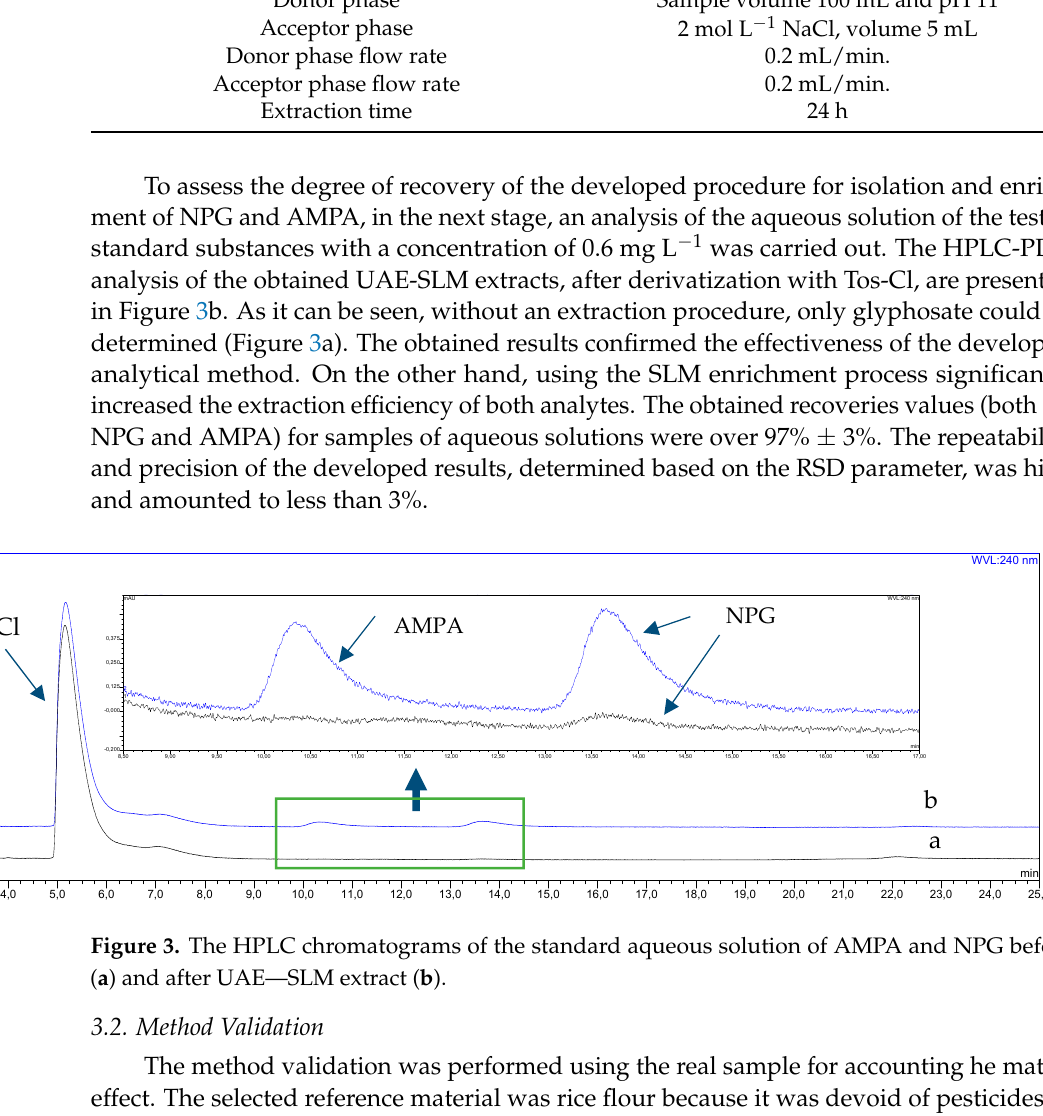
Figure 2. Effect of donor phase volume on extraction efficiency of the studied analytes. (SLM conditions—donor phase: an aqueous solution of NPG and AMPA mixture at a concentration of 0.6 mg L − 1 and pH 11 (sample volume 100 mL); acceptor phase: 2 M NaCl; membrane phase: 20% Aliquat 336 in DHE; the flow rate of the donor and acceptor phase 0.2 mL min − 1 ; extraction time: 24 h).